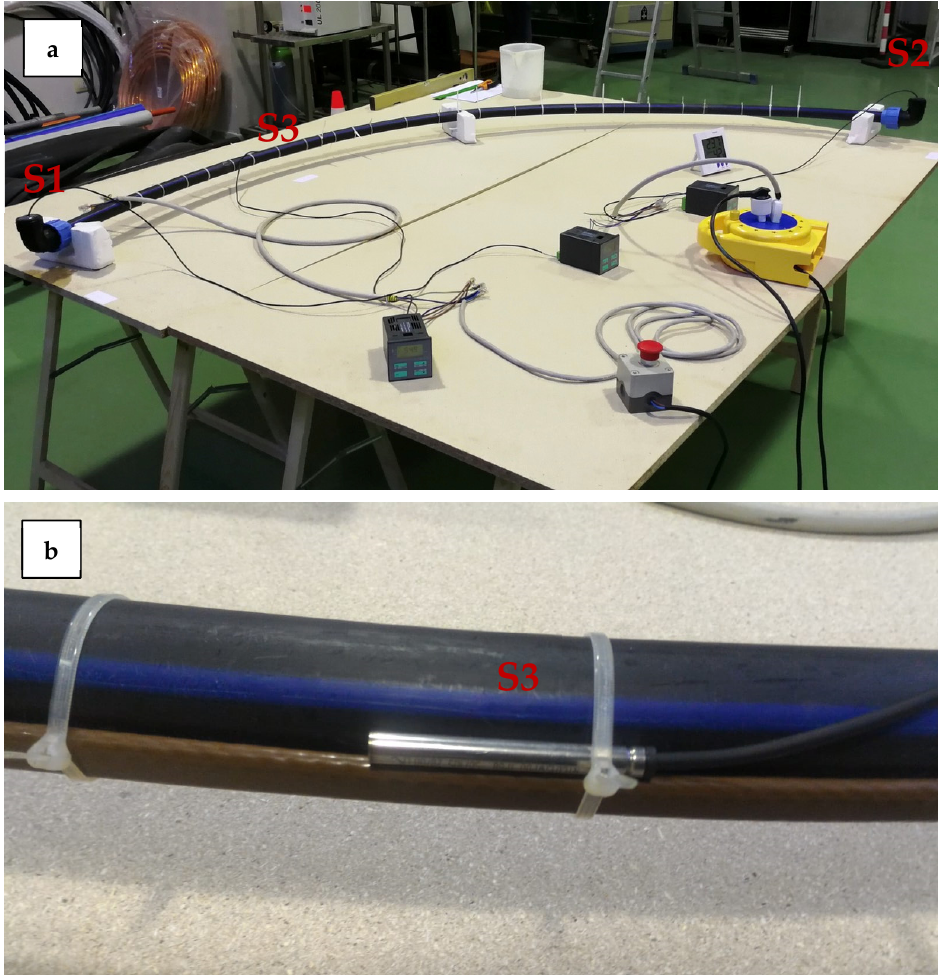
Figure 3. ( a ) Setup of the thermal test for the hybrid polyethylene probe and ( b ) detail of the temperature detection system S3 and heating cable component.